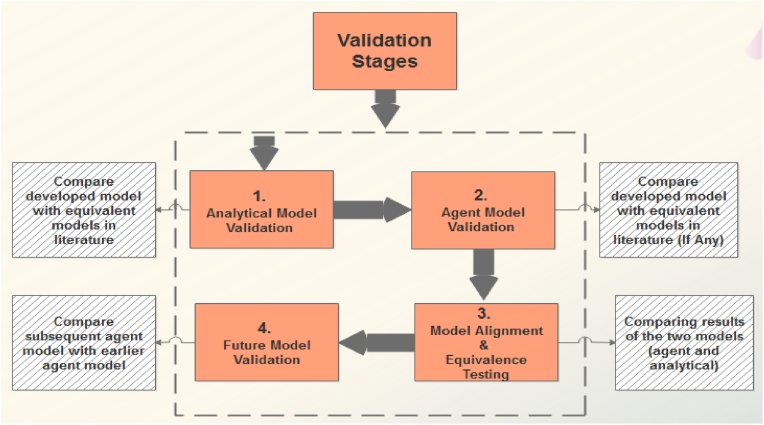
Validation Stages for A2CDSADM.